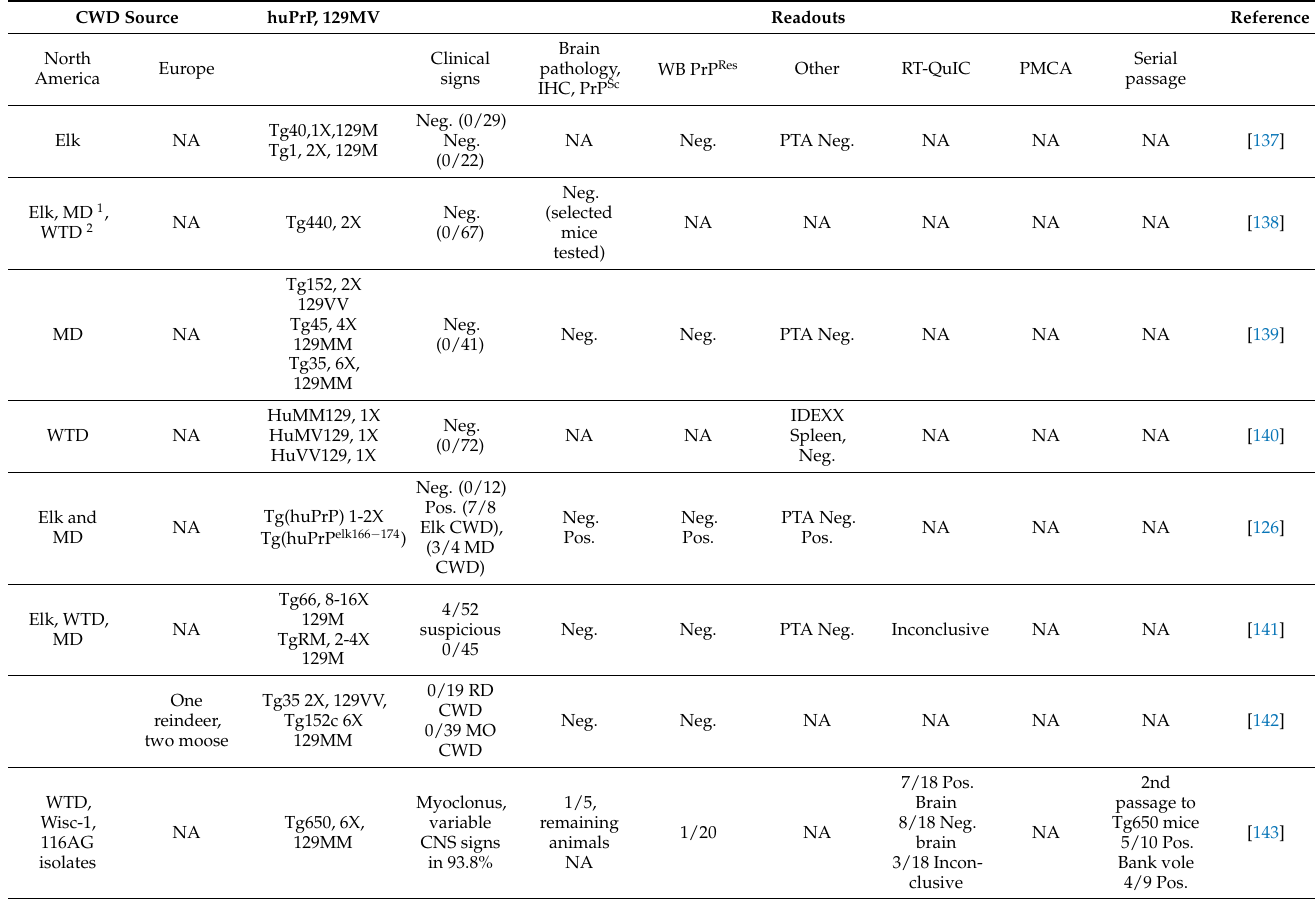
Table 3. Chronic wasting disease transmission experiments with transgenic mice expressing Human PrP (“humanized